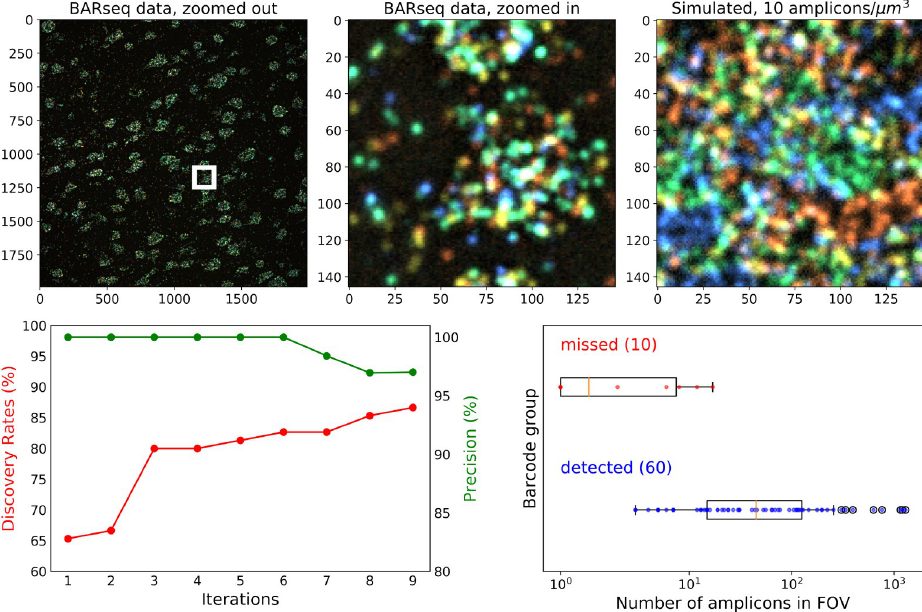
Fig 6. Barcode iterative discovery for real experimental data [16]. Top : An example image from the first round of imaging is shown on the left panel. The middle panel is a zoomed-in view of the white rectangle on the left. On the right panel, we showed the simulated data with 10 amplicons/ μ m 3 density to show that our simulation corresponds reasonably well to the real experimental data. Bottom : The result of iterative barcode discovery on the entire FOV shown on the left top panel. The discovery rate (red) and precision (green) over each iteration are shown on the left plot. We also investigated if there is an association between the barcode detection accuracy and the number of amplicons in the image that belong to that barcode. On the right panel, we show that all missed barcodes are associated with small numbers of amplicons; barcode detection can be achieved as long as we have a sufficiently large number of amplicons present in the